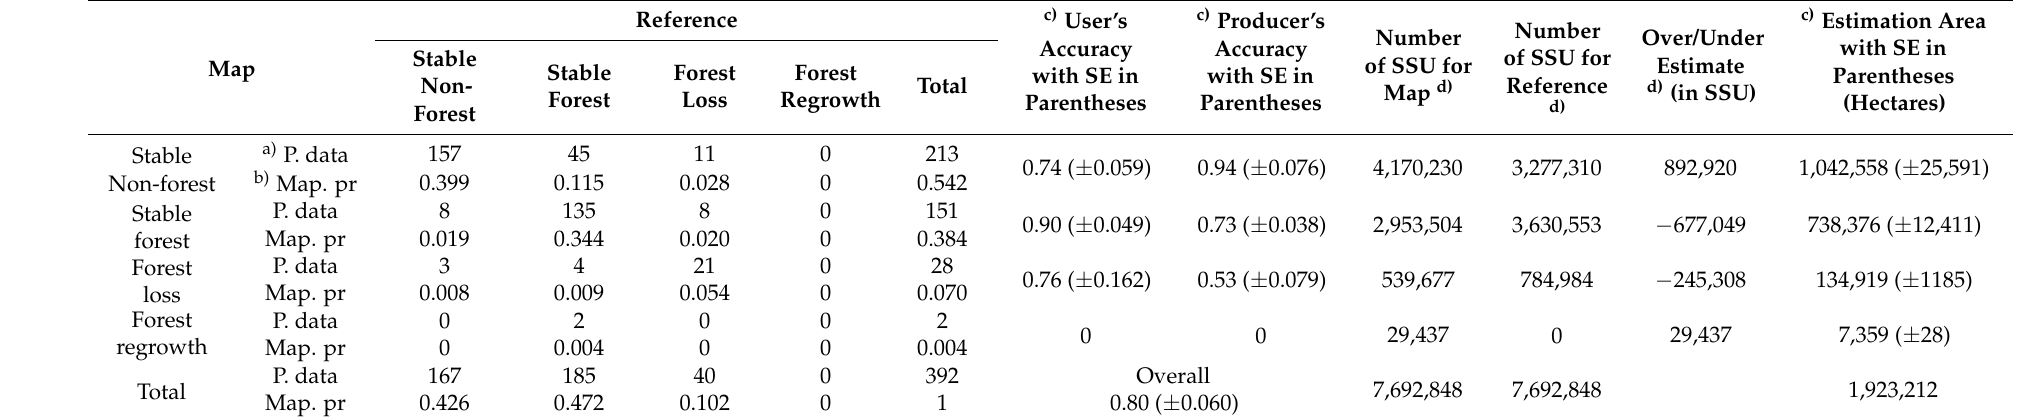
Table A4. Description of population data and map proportion area confusion matrix for the visual interpretation of land cover change map in 2006–2012.